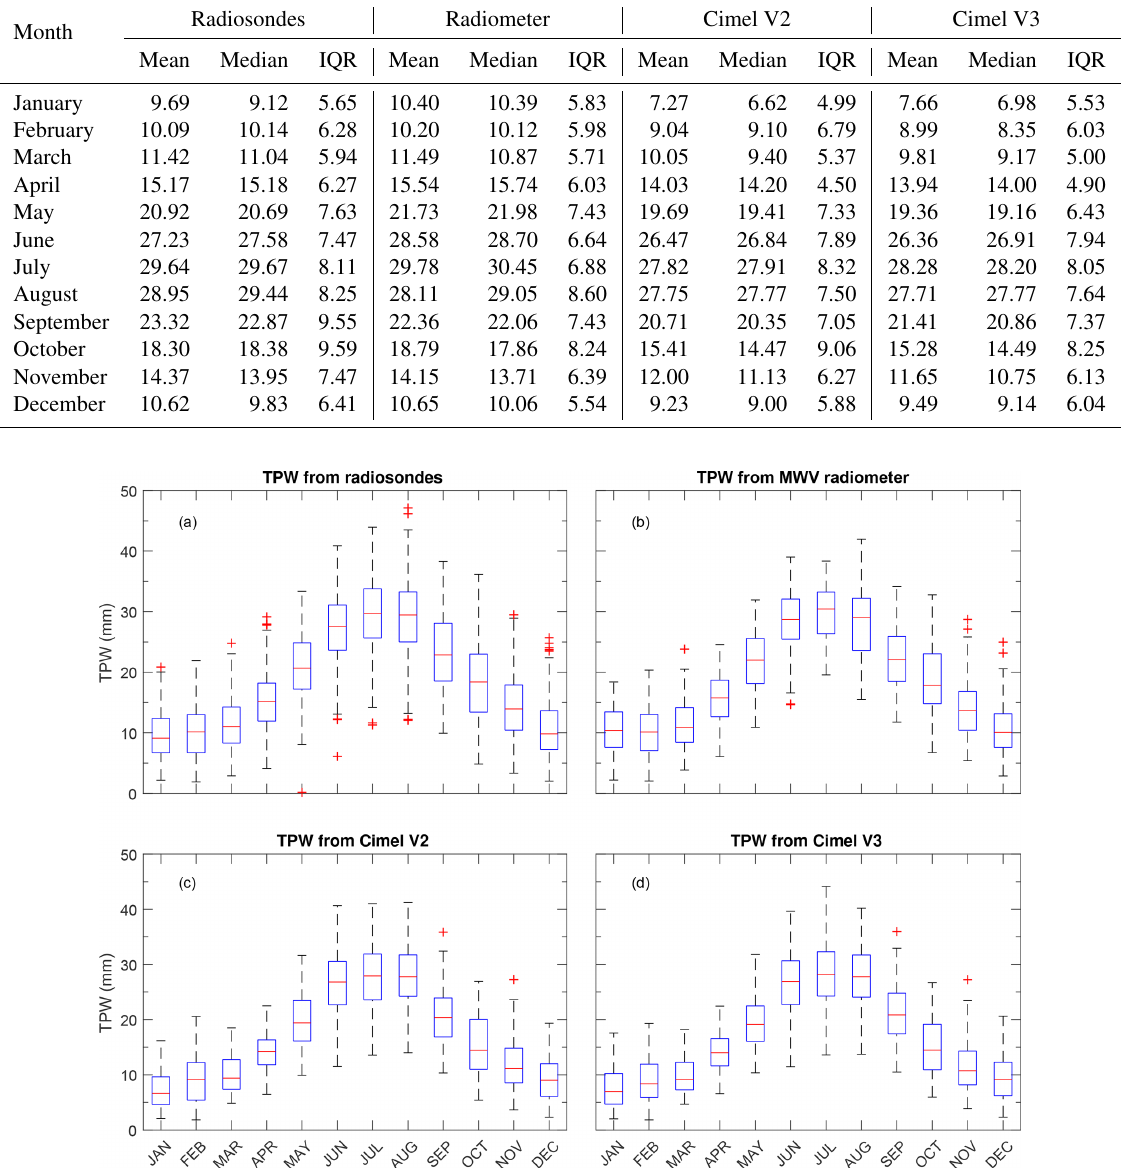
Table 3. Mean monthly and median values of TPW and their IQR from the different instruments used in this study. All units are in millimetres.